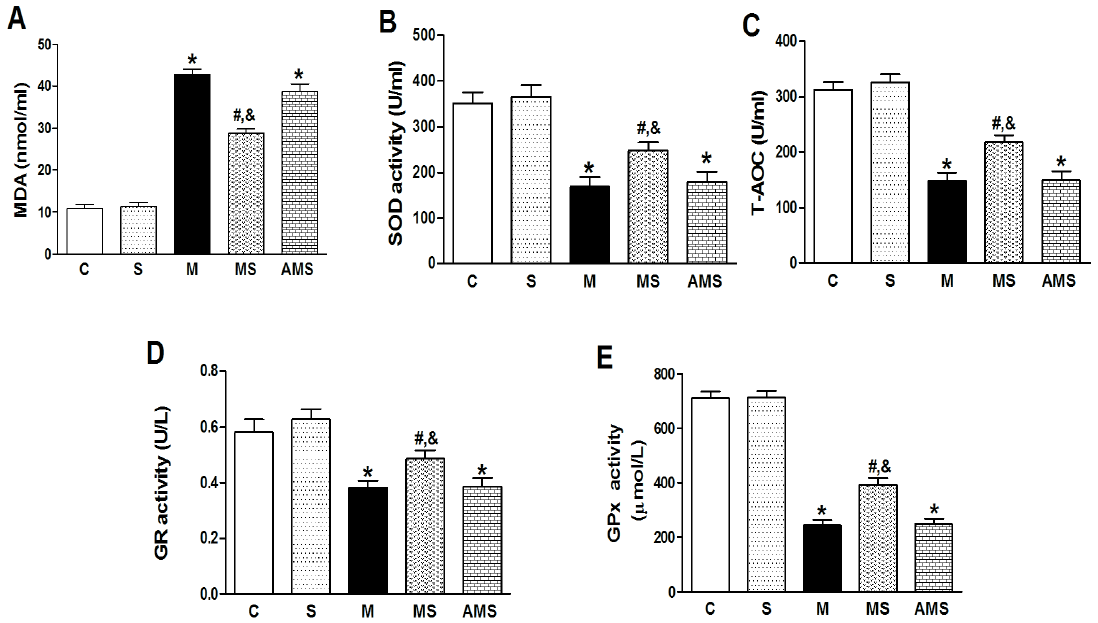
Figure 3. Changes of serum MDA, SOD, T-AOC, GR and GPx levels in each group. ( A ) MDA; ( B ) SOD; ( C ) T-AOC; ( D ) GR; and ( E ) GPx levels in serum, respectively. Data shown are mean ± SEM ( n = 6). * p < 0.05 compared with control (C); # ,& p < 0.05 compared with M and AMS,